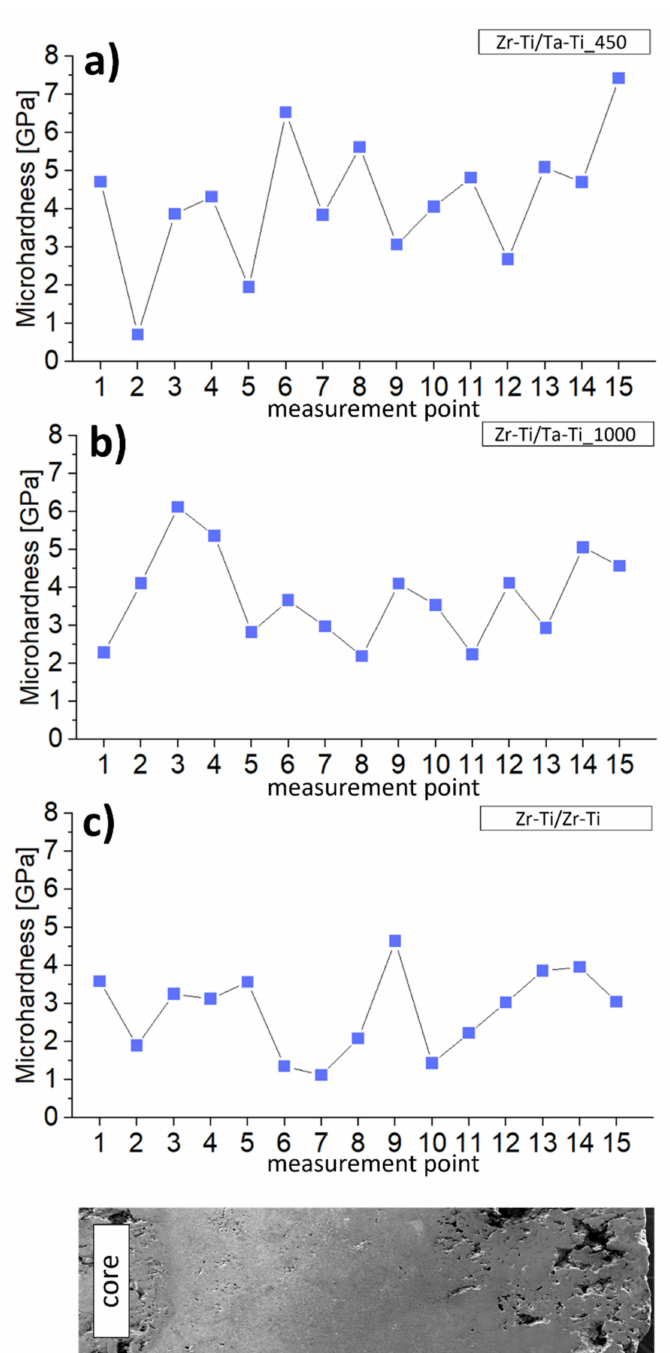
Figure 7. The relationship between the microhardness and measurement location (from core to outside zone of samples, representation at the bottom) for samples ( a ) Zr-Ti/Ta-Ti450, ( b ) Zr-Ti/Ta- Ti1000, ( c )